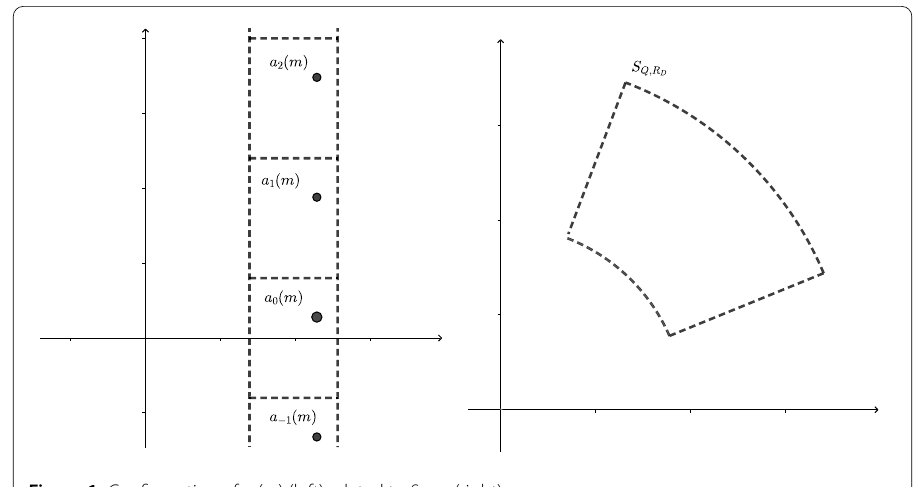
Figure 1 Configuration of a l ( m ) (left) related to S Q , RD